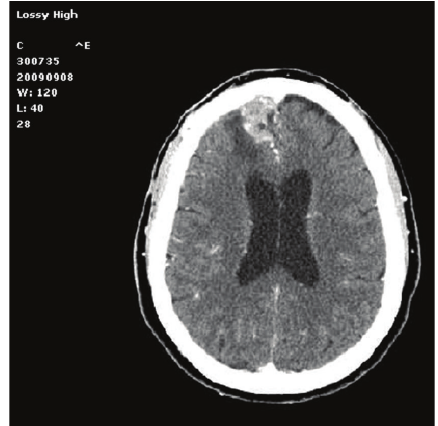
Figure 2: Contrast-enhanced axial CT scan of the postoperative intracranial granuloma.